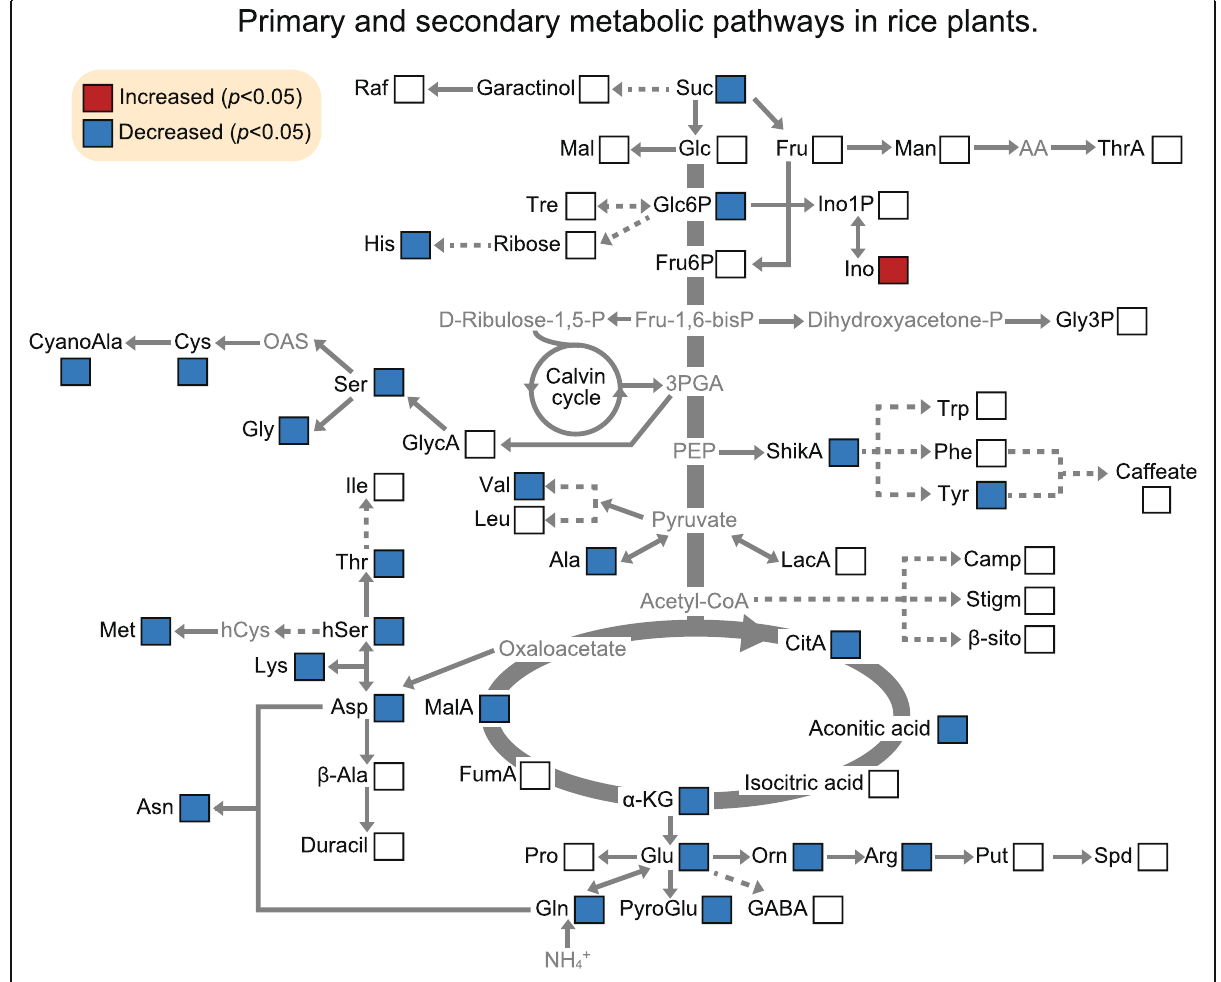
Fig. 1 Changes in metabolite levels in the basal portions of the gs1;2 mutant shoots. Seedlings were grown hydroponically in the presence of 1 mM NH 4 Cl until the fourth leaf stage. Metabolites that significantly increased in the basal portions of the gs1;2 mutant shoots relative to those of the wild type are in red boxes, while metabolites that decreased in the basal portions of the gs1;2 mutant shoots relative to those of the wild type are in blue boxes ( P < 0.05 by Student ’ s t -test). Open boxes indicate no significant difference between the wild type and gs1;2 mutants regarding metabolite levels. Compounds with gray letters could not detect by using GC-TOF-MS. Abbreviations: AA; ascorbate, Ala, alanine; β -Ala, β -alanine; Arg, arginine; Asn, asparagine; Asp, aspartic acid; Camp, campesterol; CitA, citric acid; CyanoAla, 3-cyano alanine; Cys, cysteine;